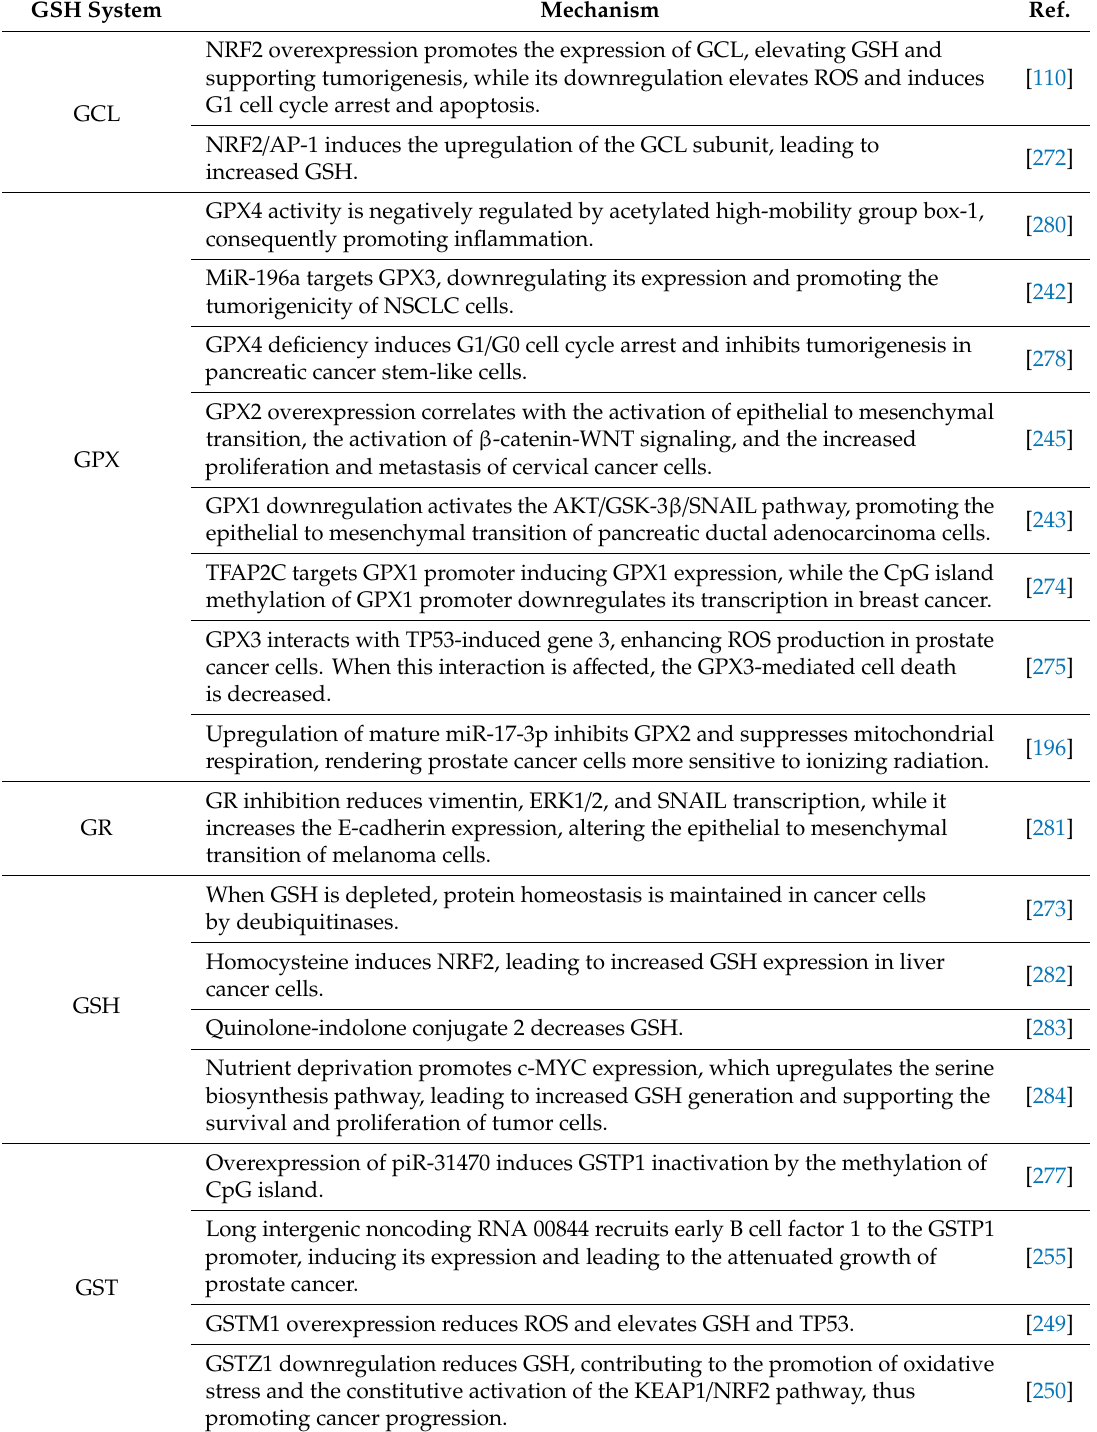
Table 5. Mechanisms of action of the GSH system in